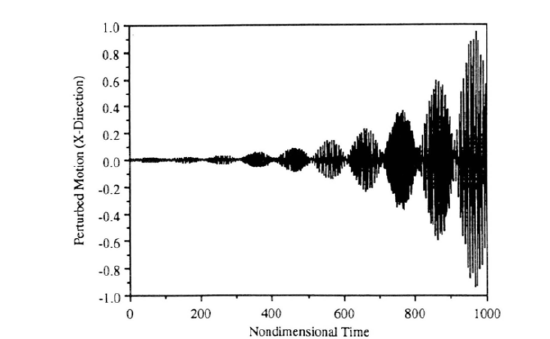
FIGURE 10 Perturbed ball motion versus nondi mensional time (w = 1.5). Initial conditions: XI (0) = .91(0) = 0.01 , i,(O) = YI(O) = 0, ¢ sl = 3.13, ¢ s2 = 3.15, ¢ I(O) = ¢ 2(0) = 0.01 , ¢I(O) = ¢2(0) = 0, m = 0.005, R = 0.001 , and {3' = .01.